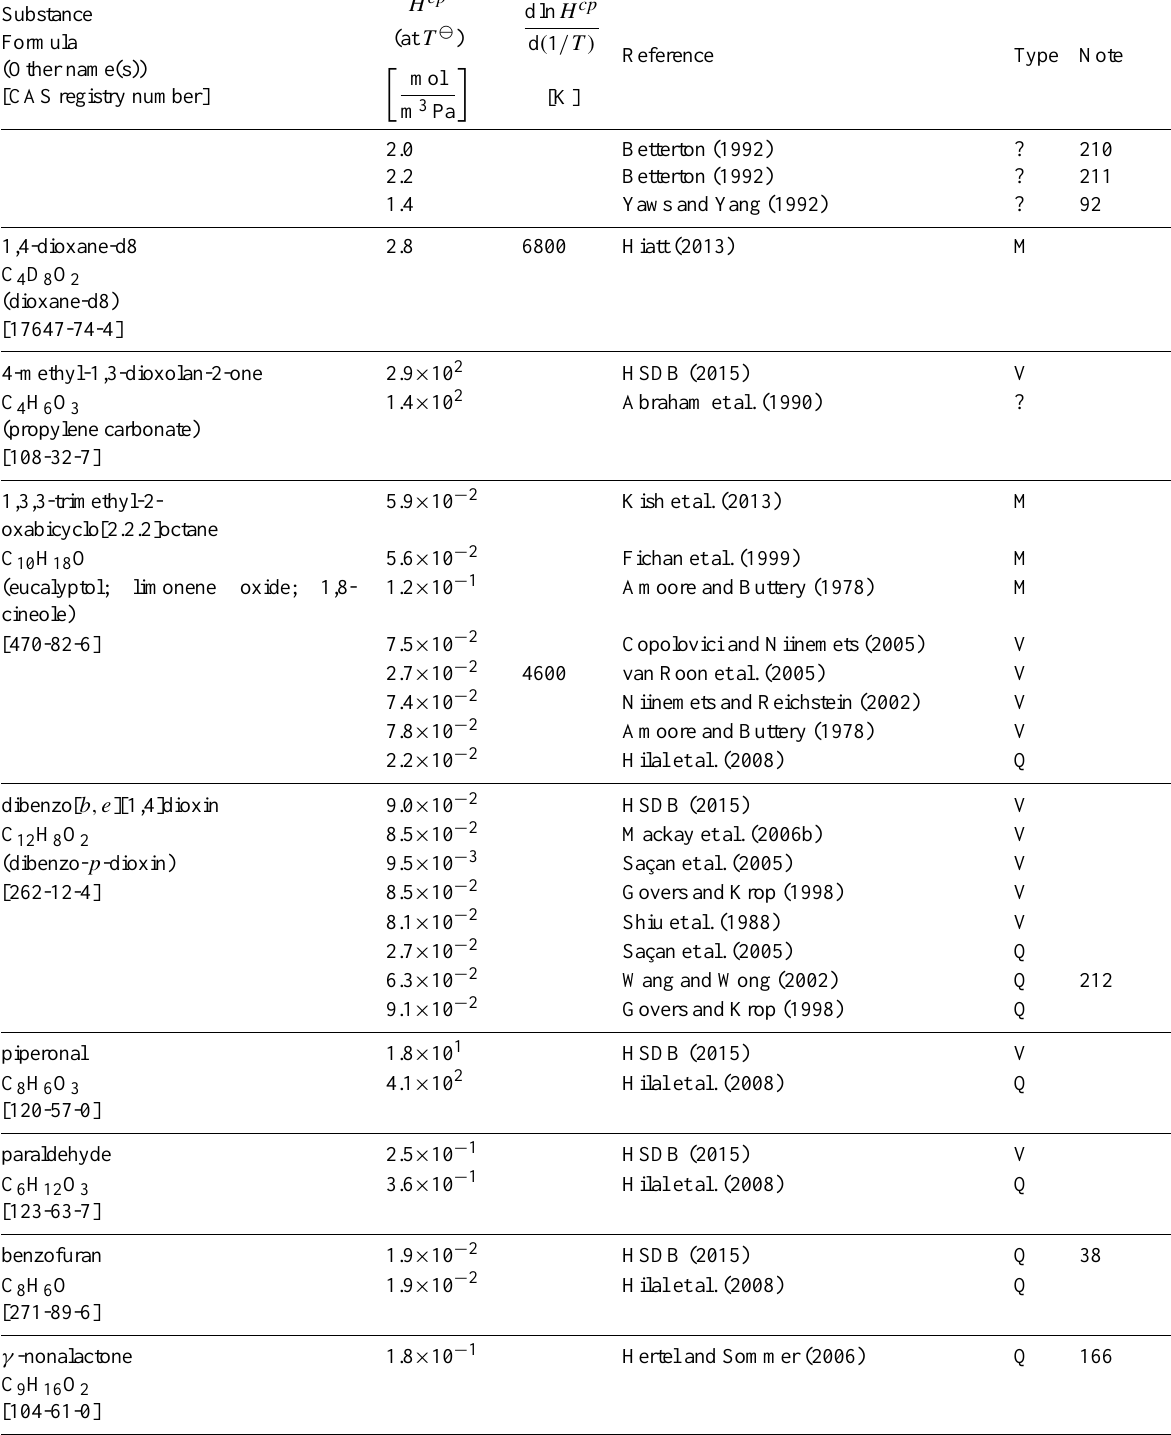
Table 6: Henry’s law constants for water as solvent